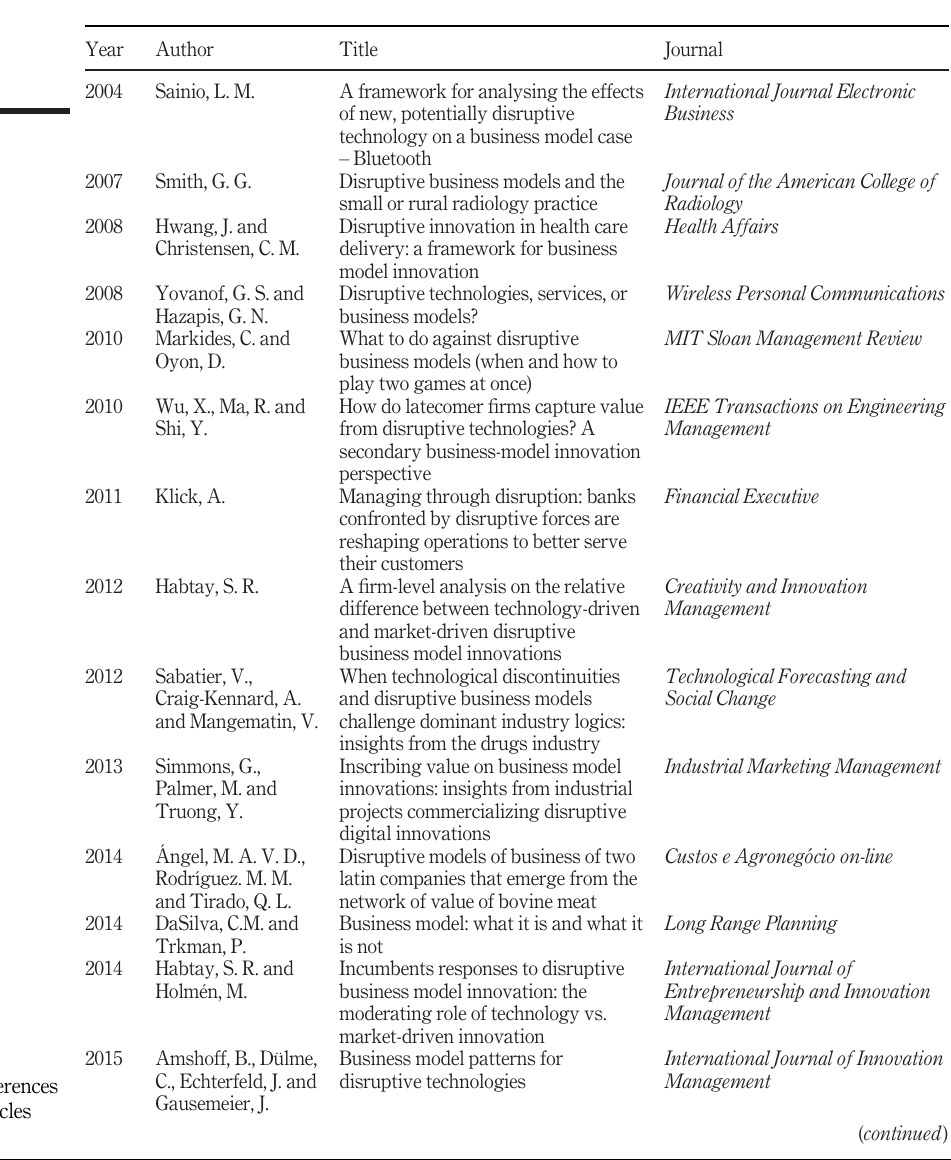
Table AI. Complete references of the 19 articles